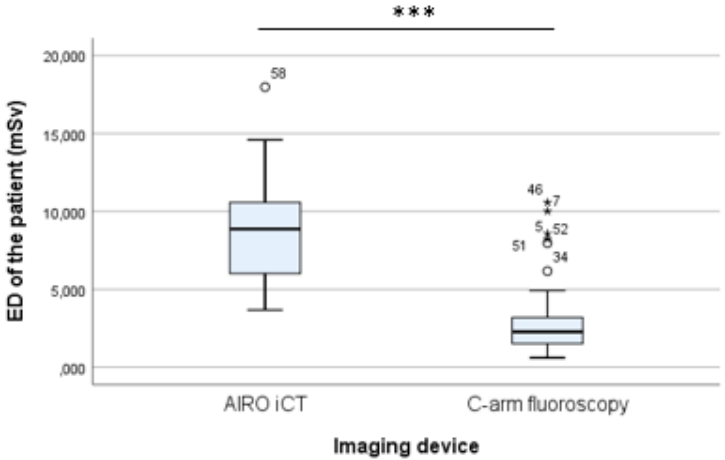
Figure 5. Effective dose (ED) of the patient during an MI-PLIF procedure. The ED of the patient (Sv) compared between surgeries assisted by iCT ( n = 24) or C-arm fluoroscopy ( n = 37). Extreme values are marked as “ ✩ ” and outliers are marked as “°” on the boxplot. Significance ( p < 0.001) is indicated with “***” above the two boxplots.